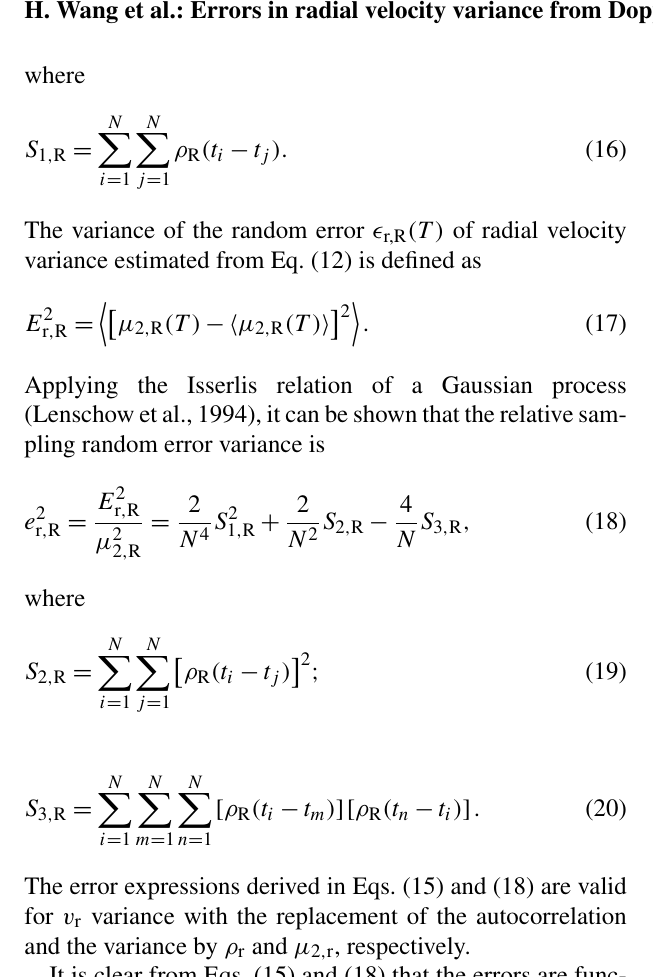
for a given time lag ( τ ) and used to represent the energy of